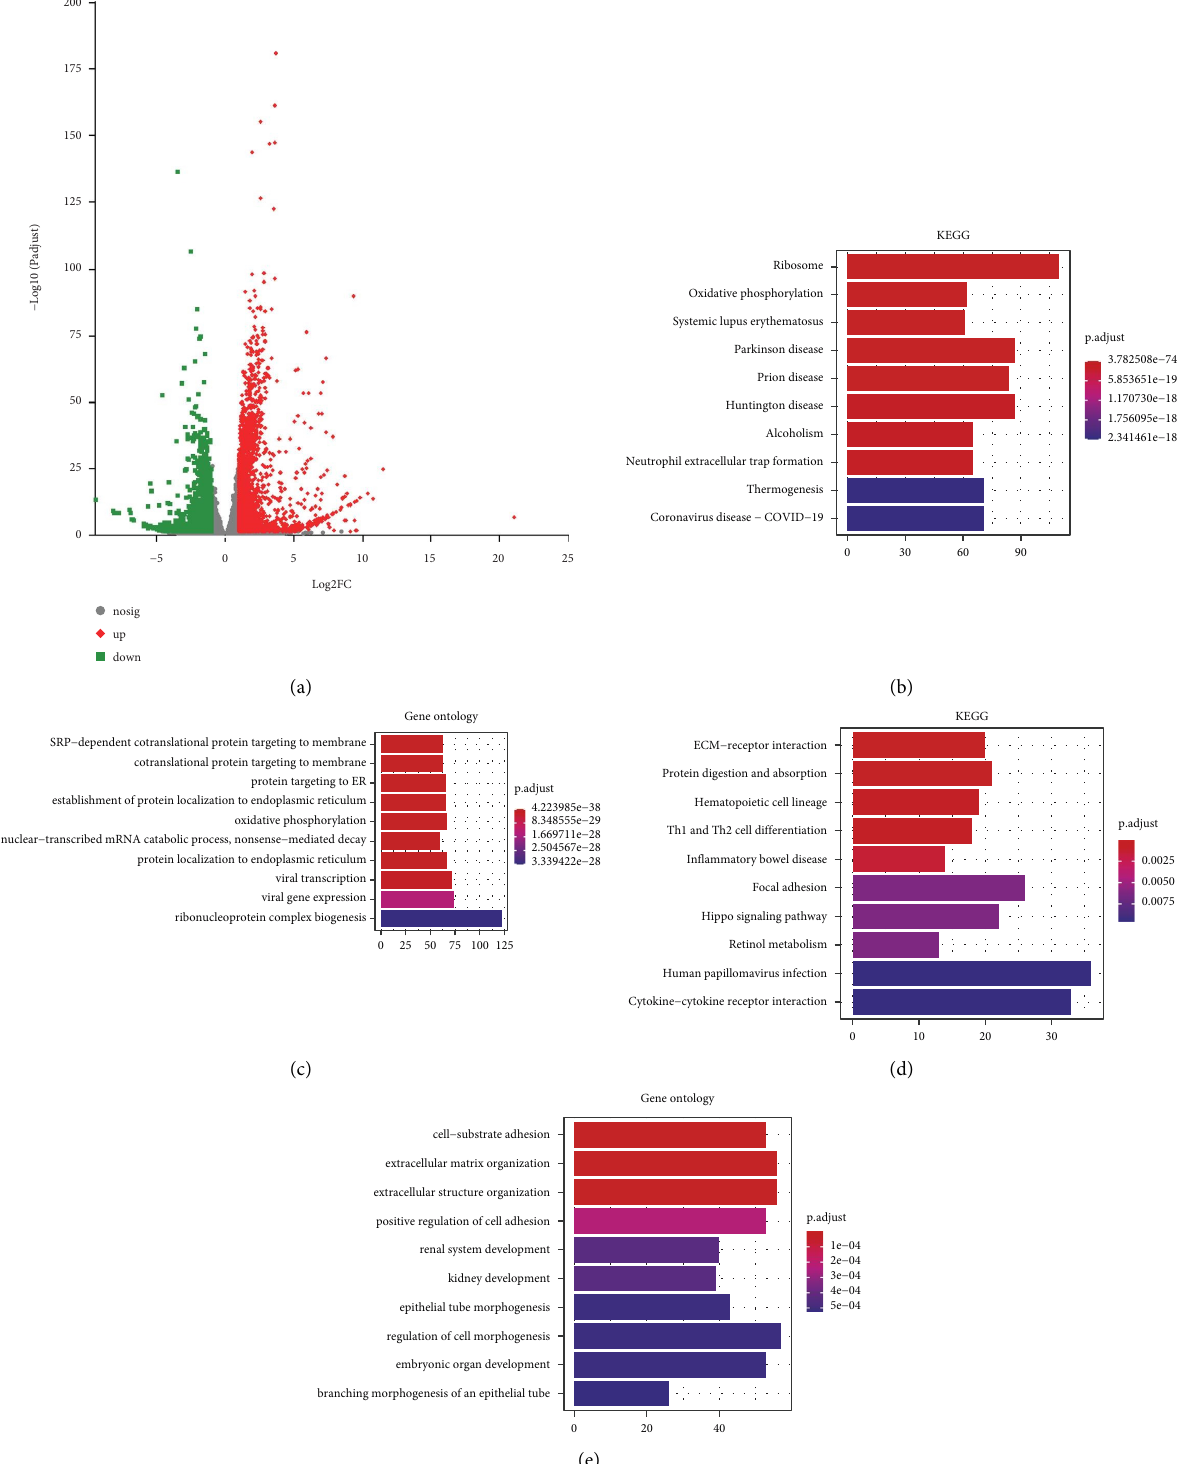
Figure 5: DEmRNAs between the hsa-miR-135b-5p inhibitor and negative control groups. (a) DEmRNAs between the hsa-miR-135b-5p inhibitor and negative control groups. Top 10 signifcantly enriched KEGG (b) pathways and GO terms (c) of upregulated mRNAs. Top 10 signifcantly enriched KEGG (d) pathways and GO terms (e) of downregulated mRNAs. Te x -axis represents the counts of the enriched genes, and the y -axis represents the GO terms or KEGG pathways. Te red strip represents high P value. KEGG, Kyoto Encyclopedia of Genes and Genomes; GO, Gene